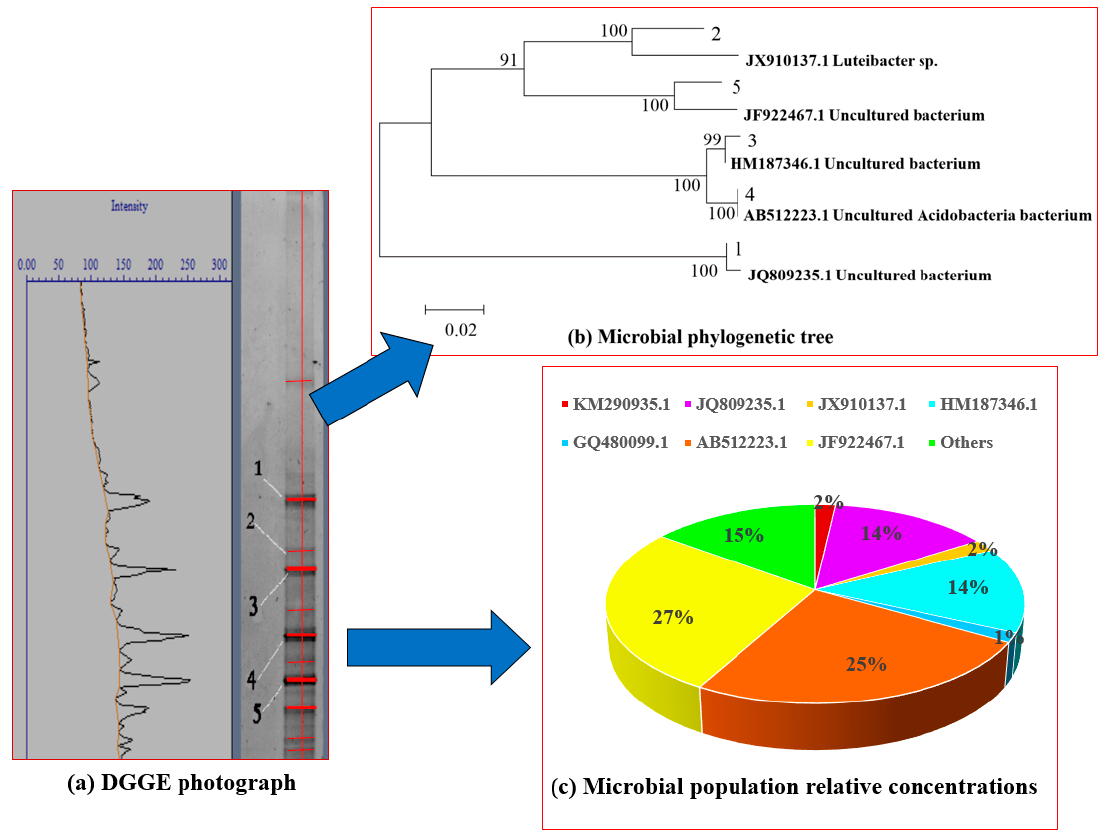
Figure 5. Microbial diversity analysis.